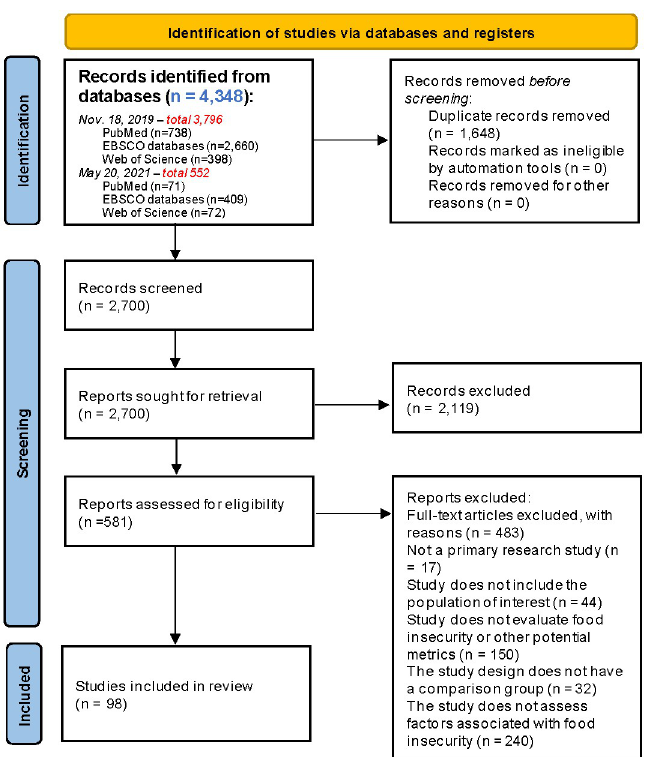
Fig 1. PRISMA 2020 flow diagram for new systematic reviews which included searches of databases and registers only. This diagram depicts the flow of information through different phases of a scoping review and maps the number of records identified, included and excluded, and exclusion justifications.